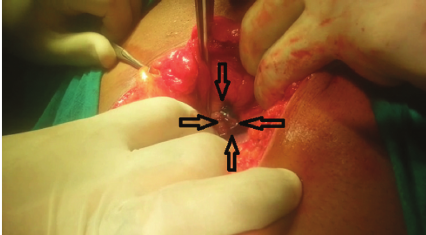
Figure 3: Intraoperative confirmation of the rent in the posterior wall marked by black arrows after instilling methylene blue per